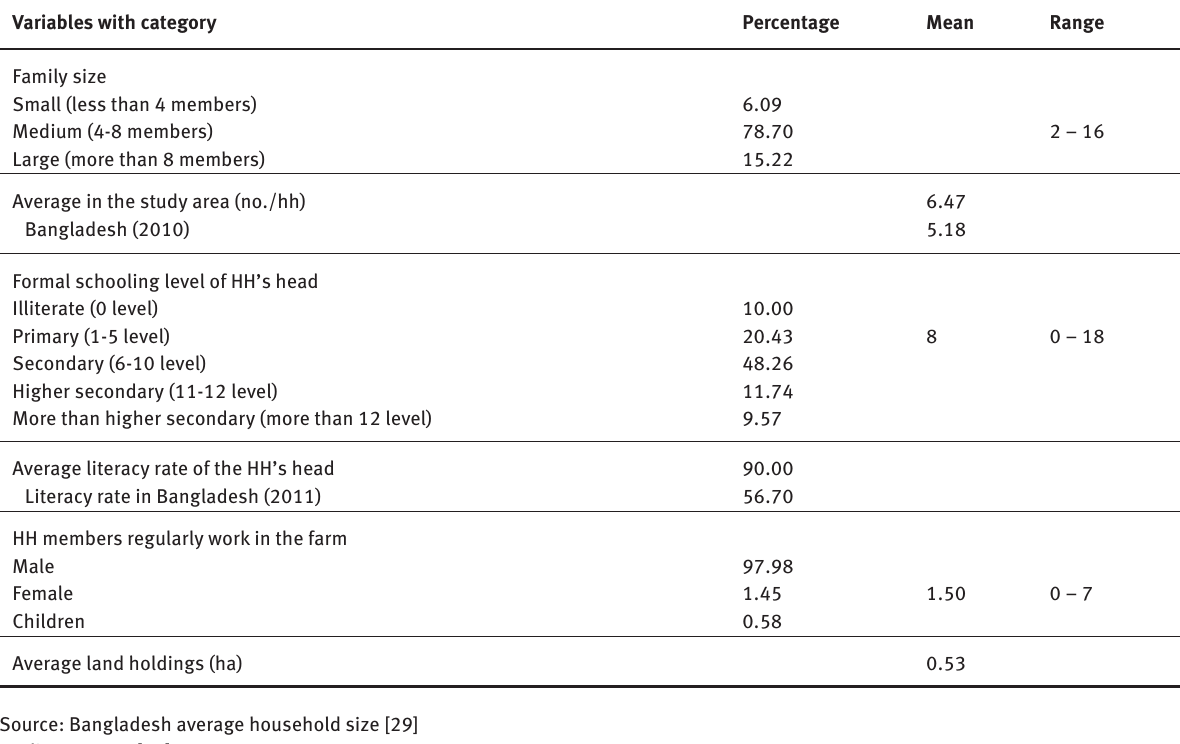
Table 1: Socio-economic characteristics of the decision maker